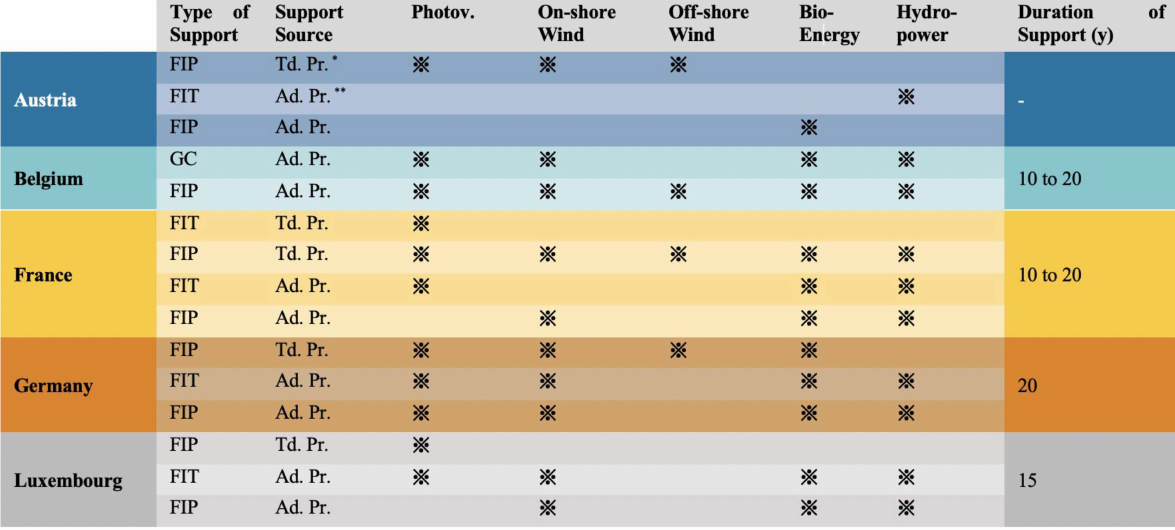
Figure 8. Energy policies 2018. * Td. Pr., tendering procedures; ** Ad. Pr., administrative